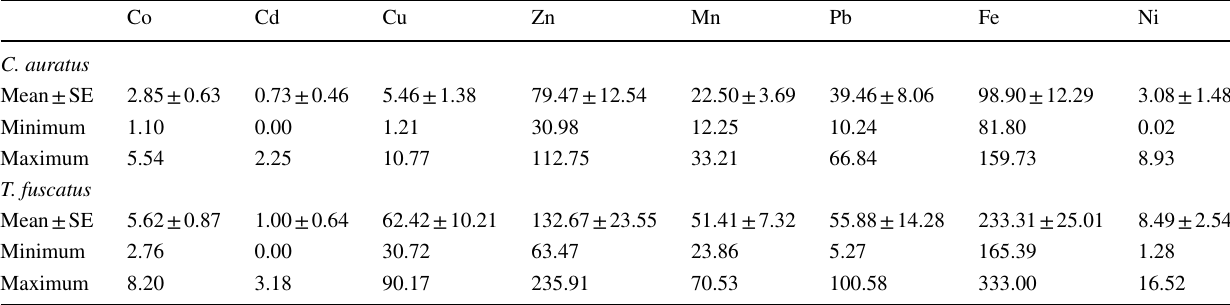
Table 5 Heavy metals concentration (ppm) of fish and periwinkle samples of Benin River